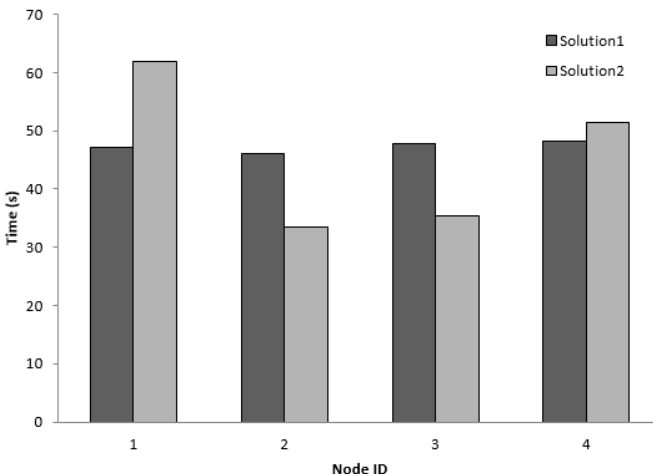
Figure 10. MEDLINE data, four nodes, heterogeneous environment.